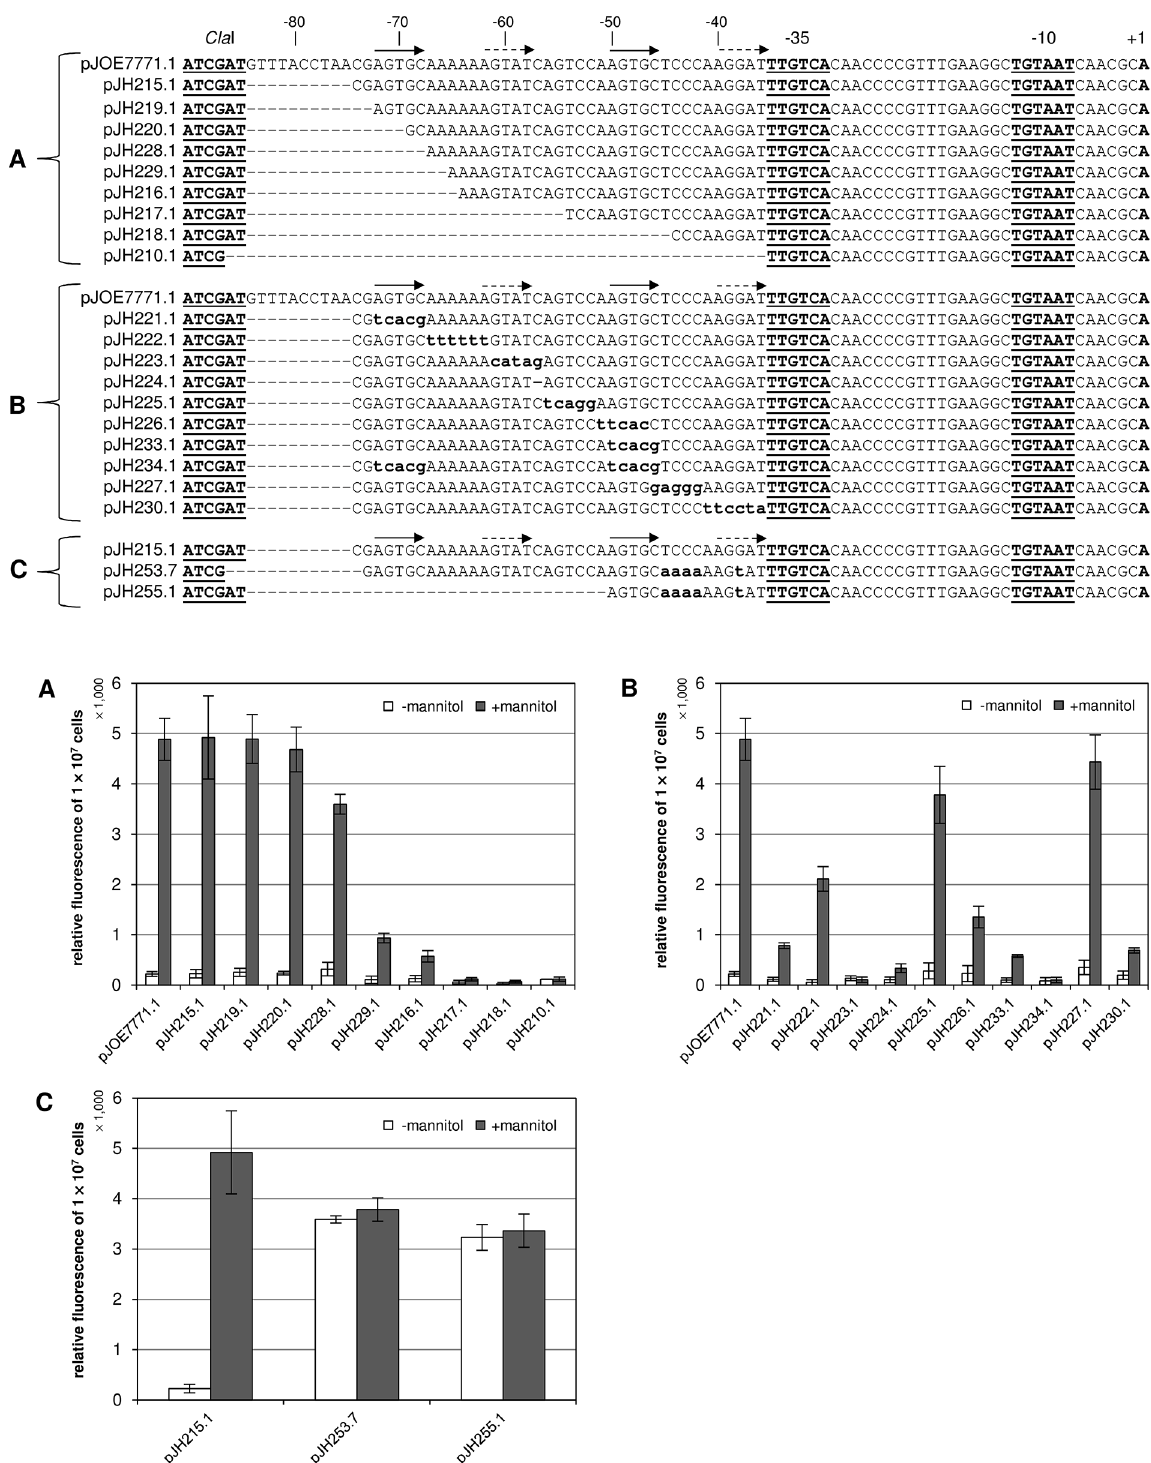
Fig 4. In vivo analysis of the MtlR binding site by fluorescence measurement of P . putida GN146 strains carrying pJOE7771.1-derived mutant plasmids. The nucleotide sequences of the wild type (pJOE7771.1) and the mutants are shown. Mutated nucleotides are typed in lowercase. Perfect direct repeats are indicated by solid arrows. Similar direct repeats are indicated by dashed arrows. Fluorescence was measured 6 h after addition of mannitol. (A) Mutants with truncated 5 ’ sequences. (B) Mutants with blocks of base substitutions. (C) Mutants with doubled or shifted 15 bp sequence stretch -72 to -58.